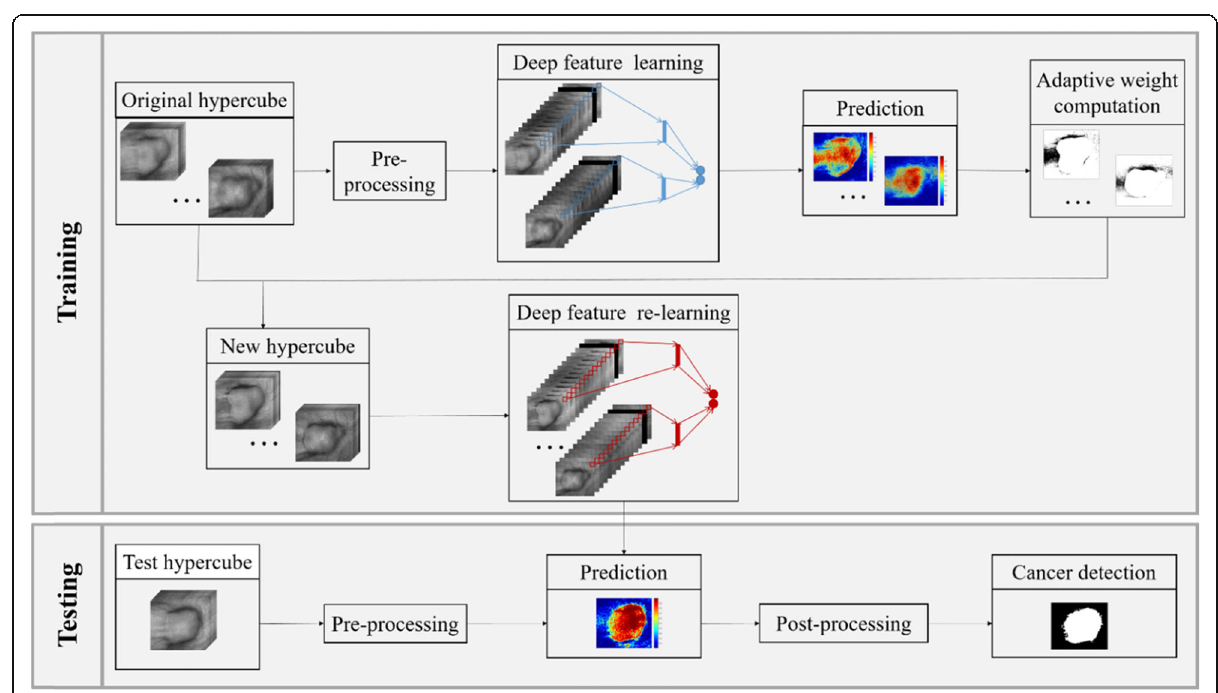
Fig. 1 Overview of the proposed adaptive deep learning method for cancer detection with hyperspectral